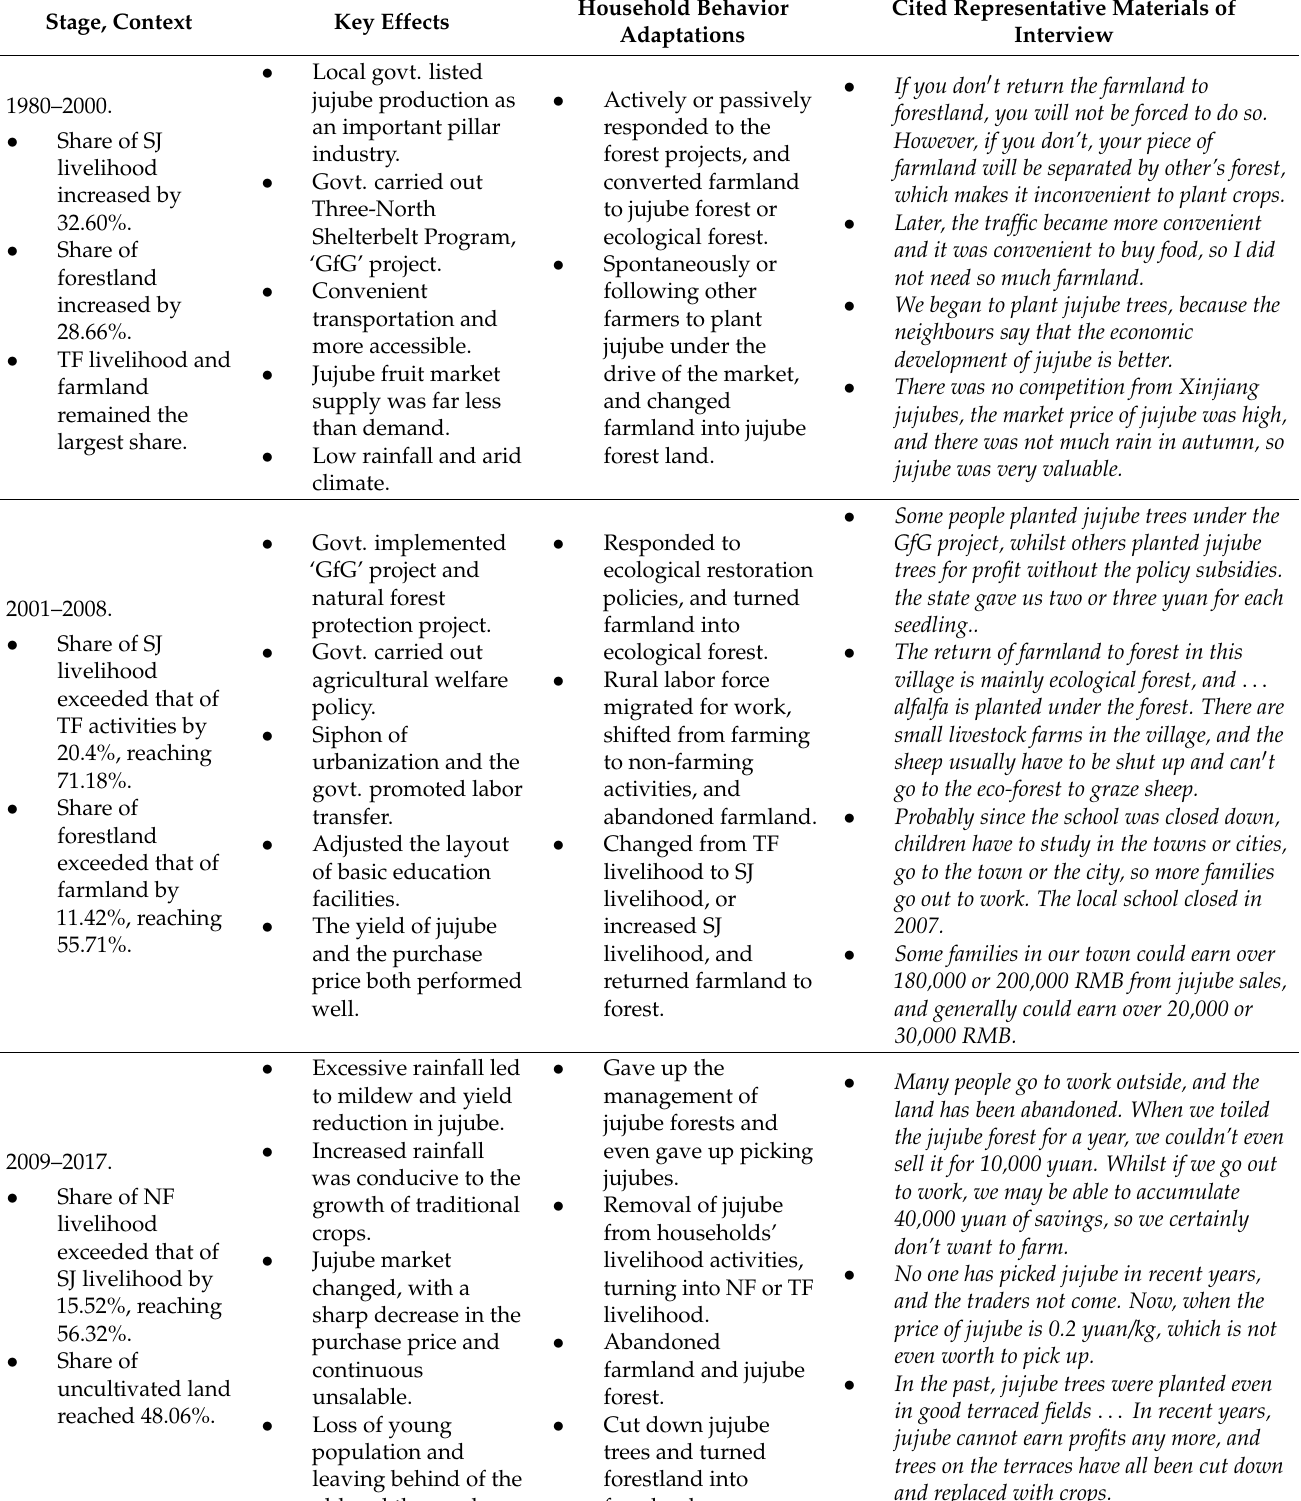
Table 3. A synthesis of livelihoods–land use transitions, key effects, household behavior adaptations, and cited interview materials at three